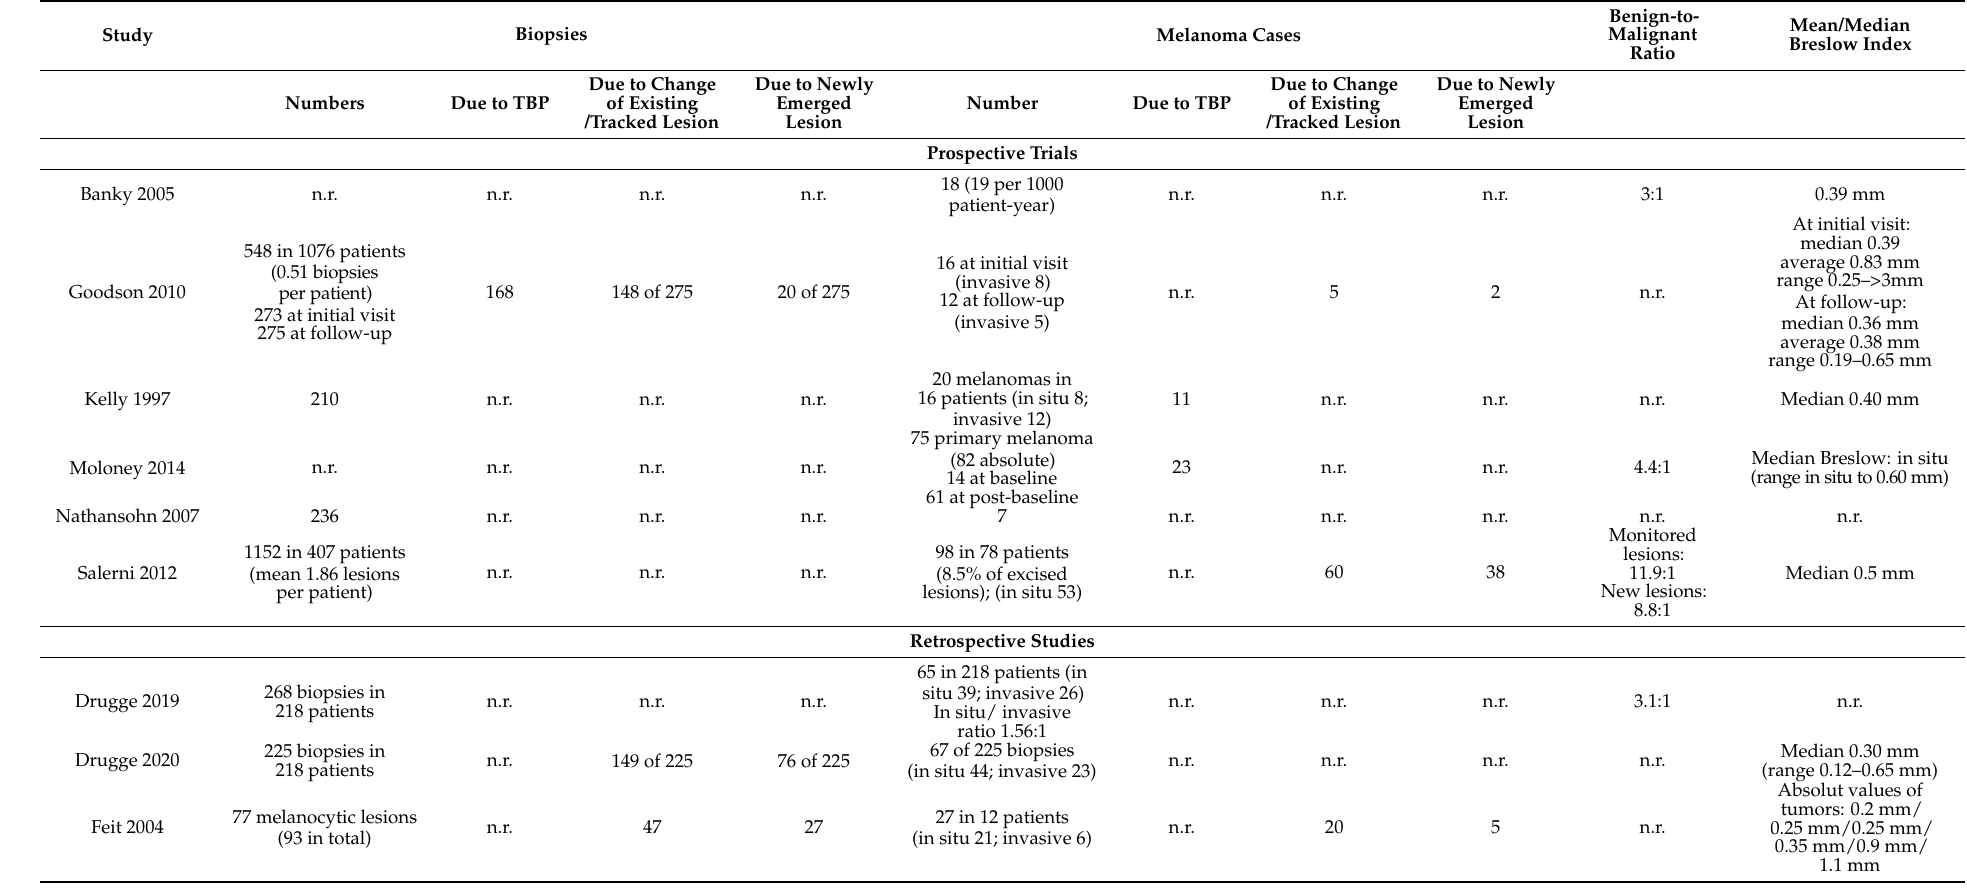
Table 3. Summary of the Outcomes of Interest of the Included Studies without a Relevant Comparison of TBP vs.